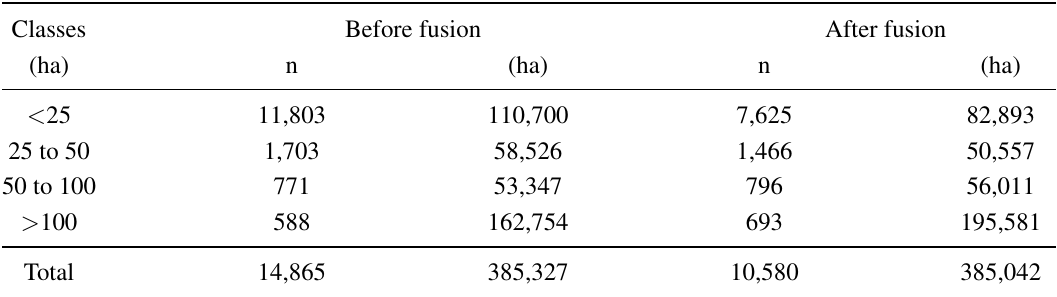
Table 3. Number of polygons (n) and deforested area (ha) classified by size (ha) before and after fusion of adjacent